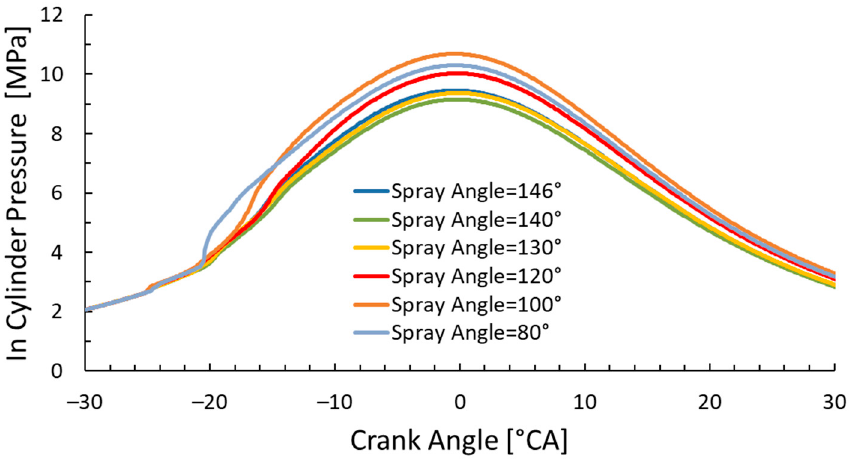
Figure 25. Effect of SIA on in-cylinder pressure history for an ESI with SOI of − 50 °CA ATDC.